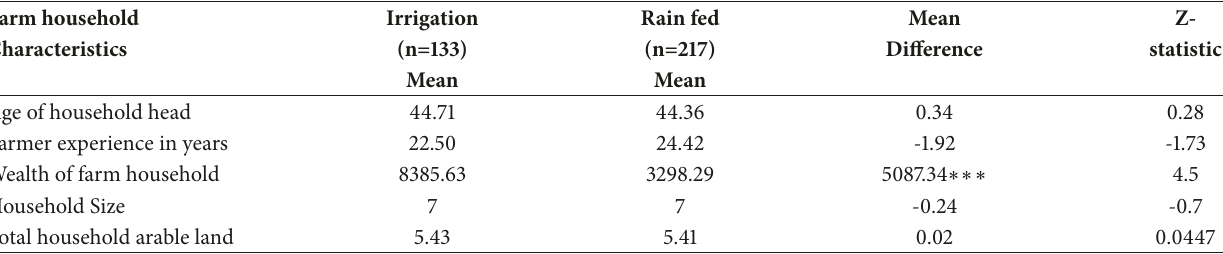
Table 3: Production ecology effect of means of farm household’s characteristics.